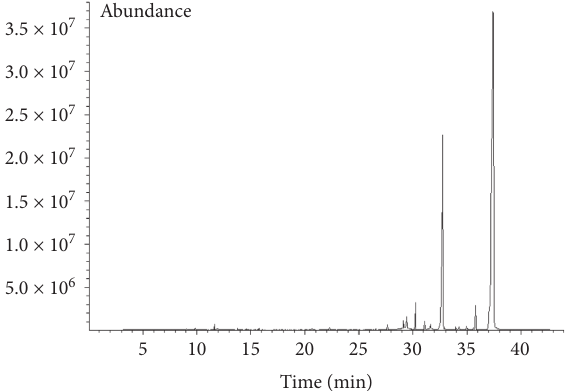
Figure 2: Total ion flow chromatogram of components in ethanol extract.